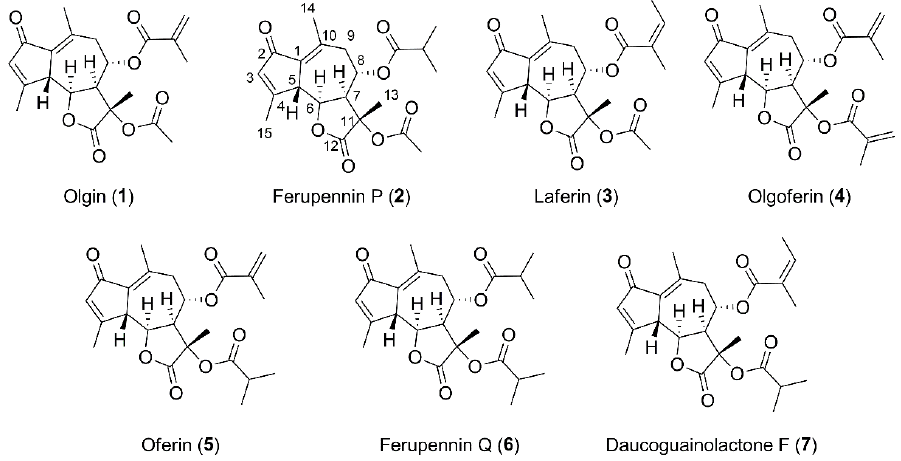
Figure 3. Chemical structures of the seven guaiane ‐ type sesquiterpene lactones isolated from Ferula penninervis methanolic root extract. Table 2. 1 H NMR (600 MHz) and 13 C NMR (151 MHz) data of ferupennin P ( 2 ) and ferupennin Q ( 6 ) in CD 3 OD; δ in ppm; J in